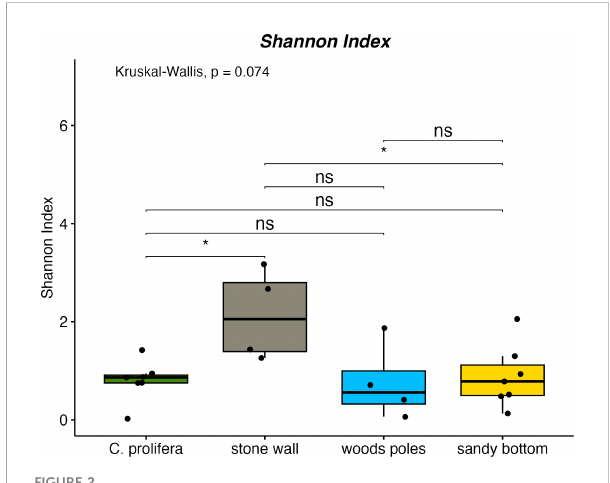
FIGURE 2 Shannon index for investigated habitats. * means "p-value ≤ 0.05" and "ns" means not signi fi